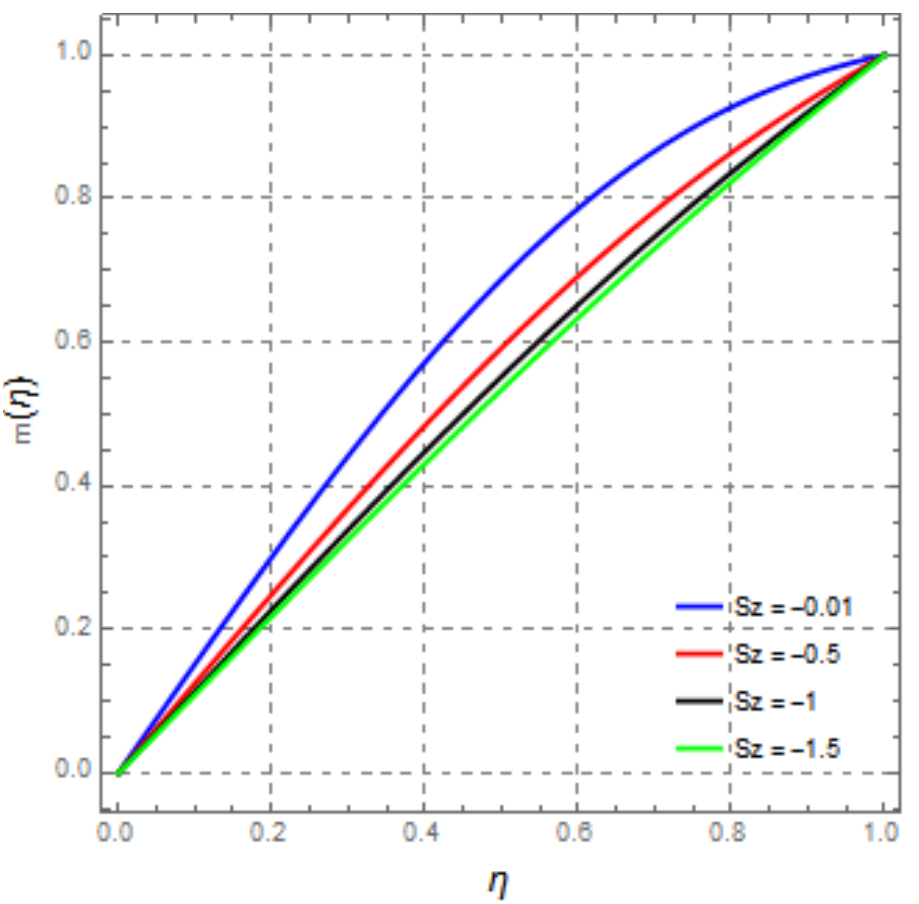
Figure 6. Impact of squeeze reynolds number S z on velocity component g and n , keeping M x = − 1, M y = 0.5, R m = − 0.75, and S = 1.